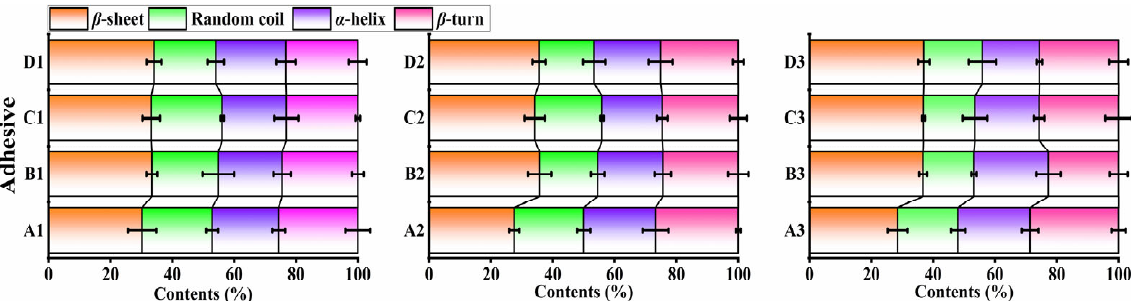
Figure 3. Secondary structure of A1 ‐ pure HPMP, B1 ‐ SDS/HPMP, C1 ‐ SDS/nSiO 2 /HPMP, D1 ‐ HPMP adhesives, A2 ‐ pure SBMP, B2 ‐ SDS/SBMP, C2 ‐ SDS/nSiO 2 /SBMP, D2 ‐ SBMP adhesives, A3 ‐ pure CSMP, B3 ‐ SDS/CSMP, C3 ‐ SDS/nSiO 2 /CSMP, and D3 ‐ CSMP adhesives.